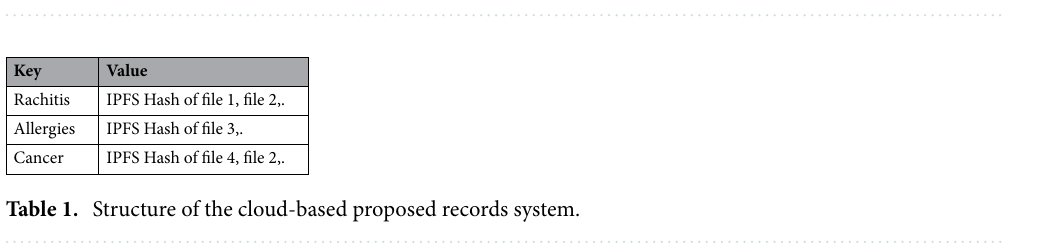
Figure 3. A sequence diagram of a search process in the system through which file type and the keywords are entered (additionally, it is possible to enter the time range), encrypted, and searched in the cloud, which together generate the results.